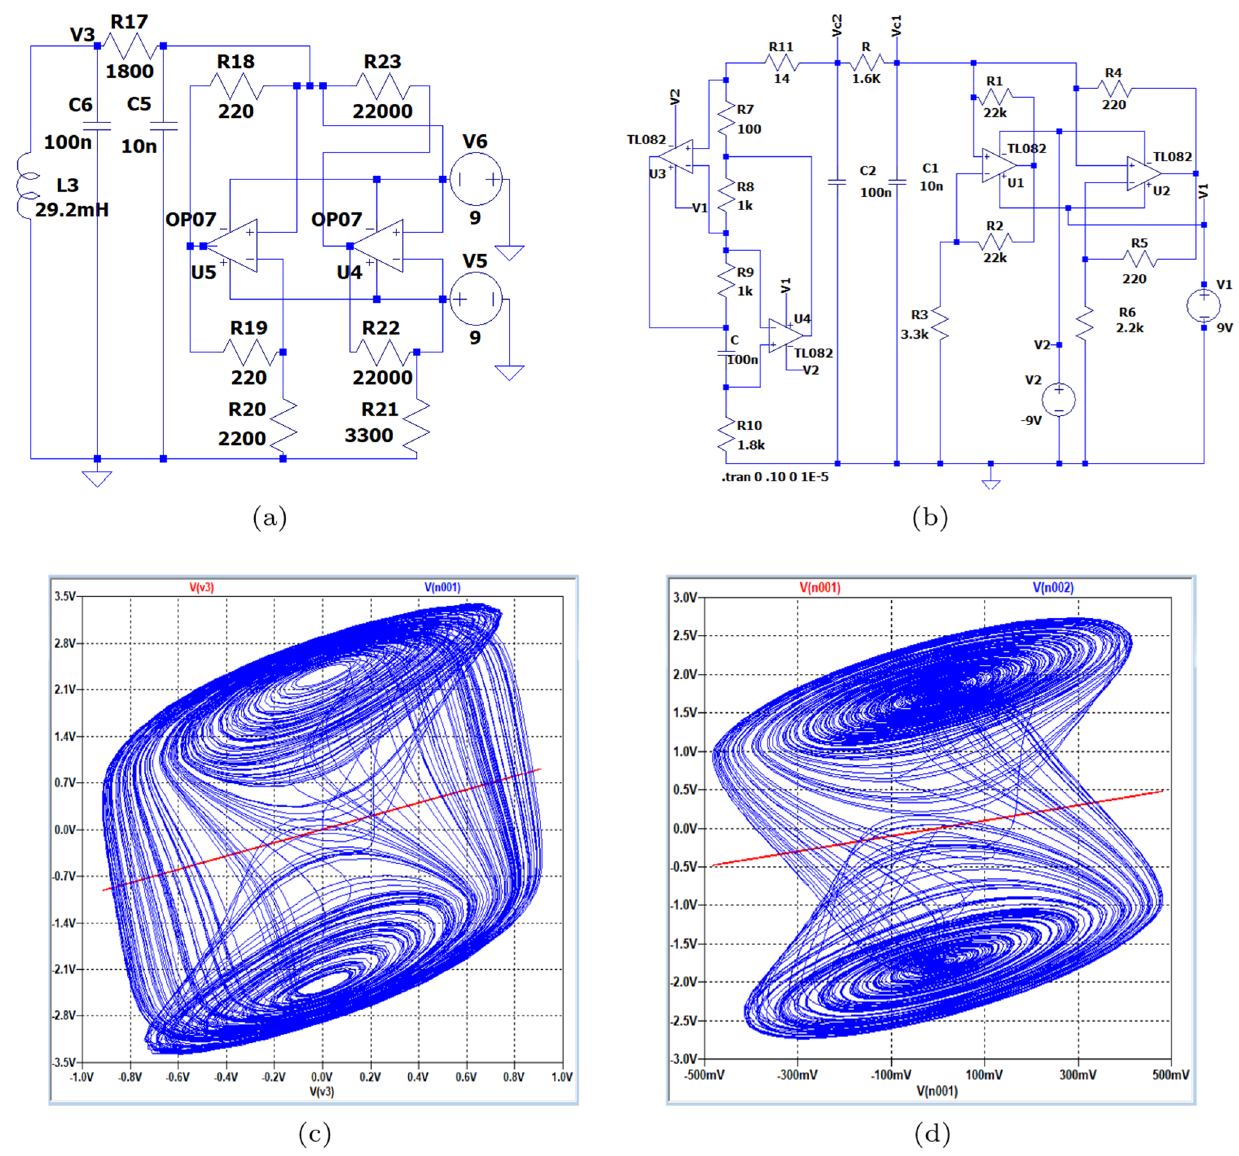
Fig. 4 LTSpice design of Chau’s chaos a With Inductor (L), b Without Inductor (L). The attractor c Corresponds to design in a , and d Corre- sponds to design in